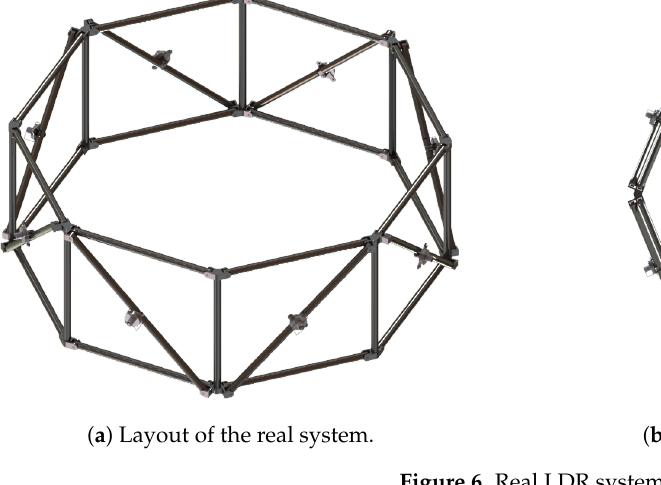
Figure 6. Real LDR system.